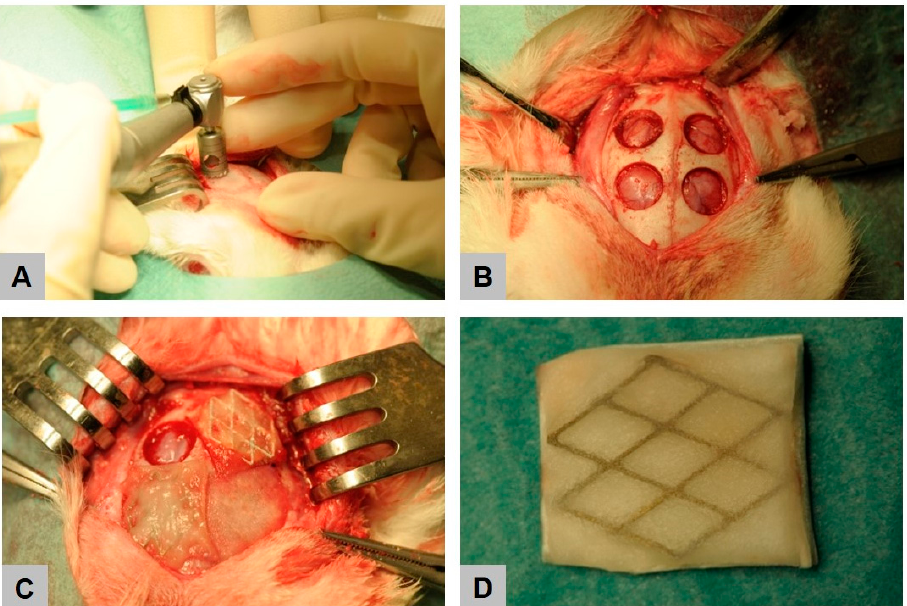
Figure 10. Intraoperative view on calvarial implantation model. Creation of four circular defects using a trephine burr ( A , B ), followed by placement of membranes ( C ). Image of the hydrofluoric acid (HF)-treated magnesium (Mg) mesh in a native collagen membrane (D ).